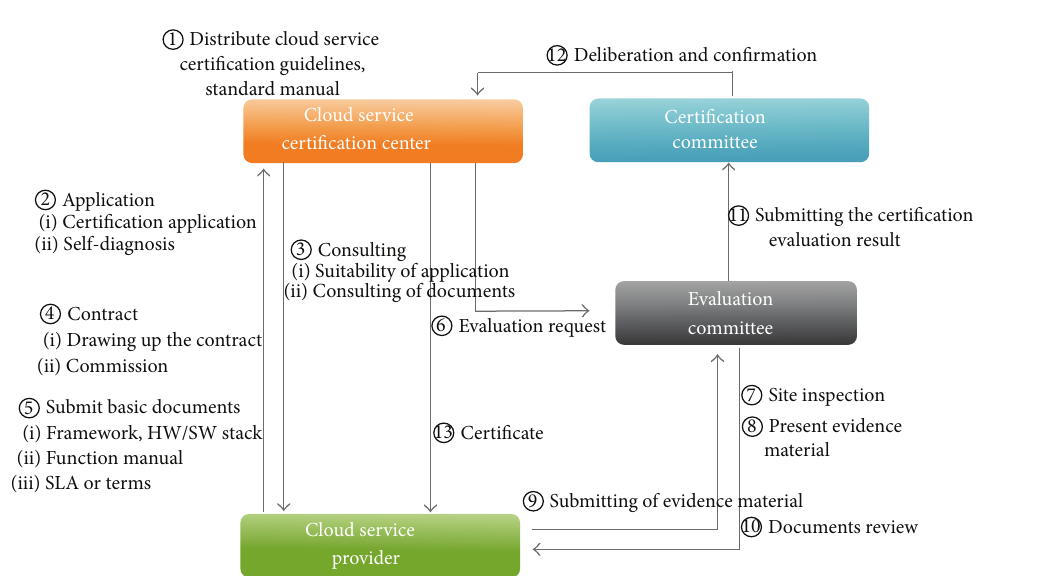
Figure 3: Certification flow of the Korea cloud service certification system.